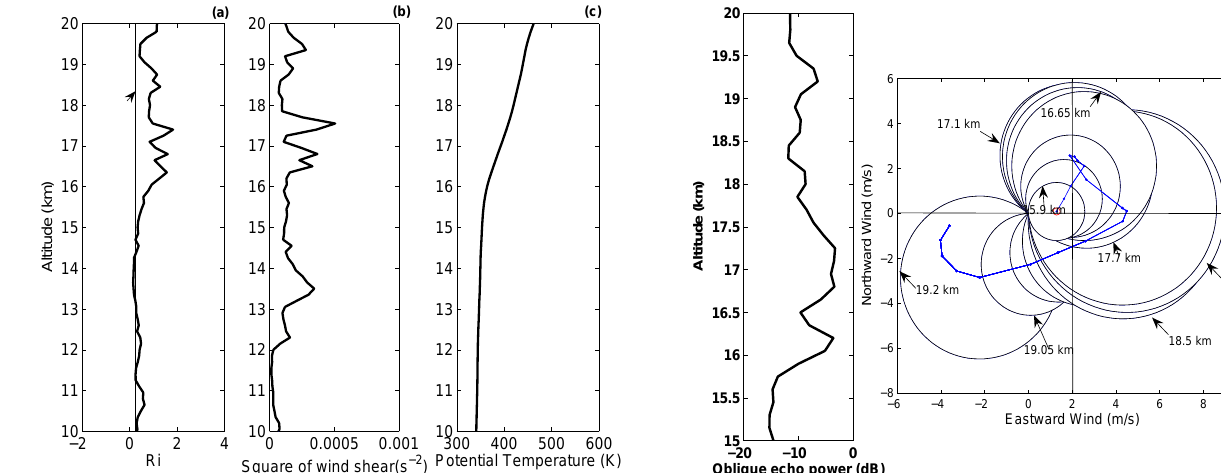
Fig. 11. Hodogram of winds to provide centers of critical circles and critical circles for different heights to identify regions of poten- tially strong